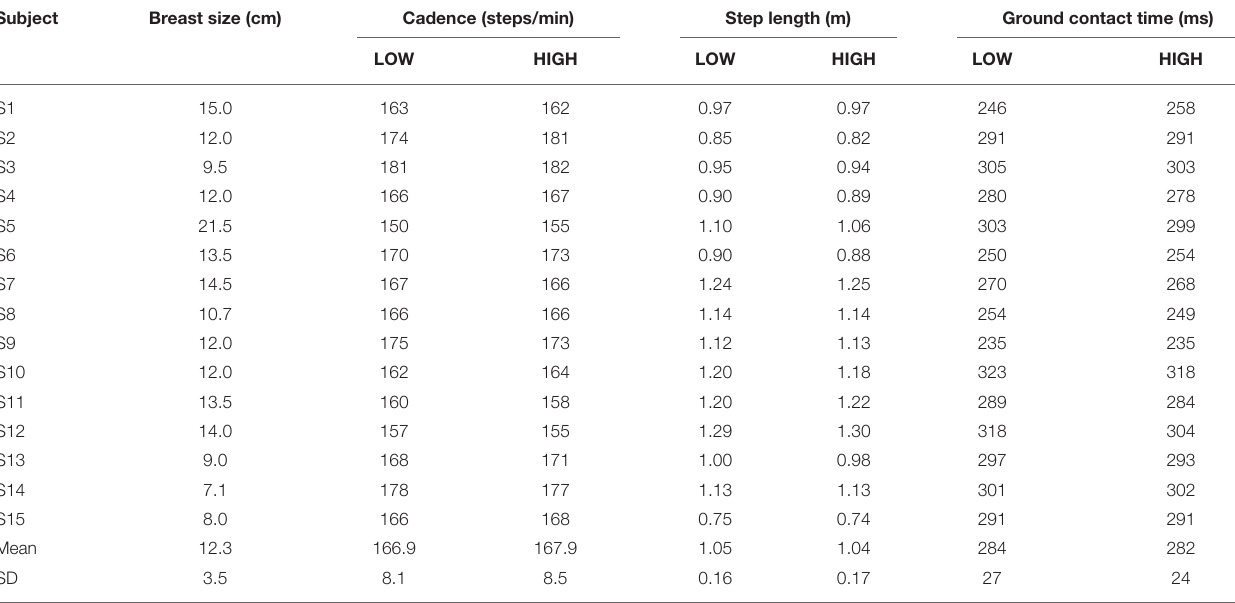
TABLE 4 | Average temporospatial characteristics in the LOW and HIGH support